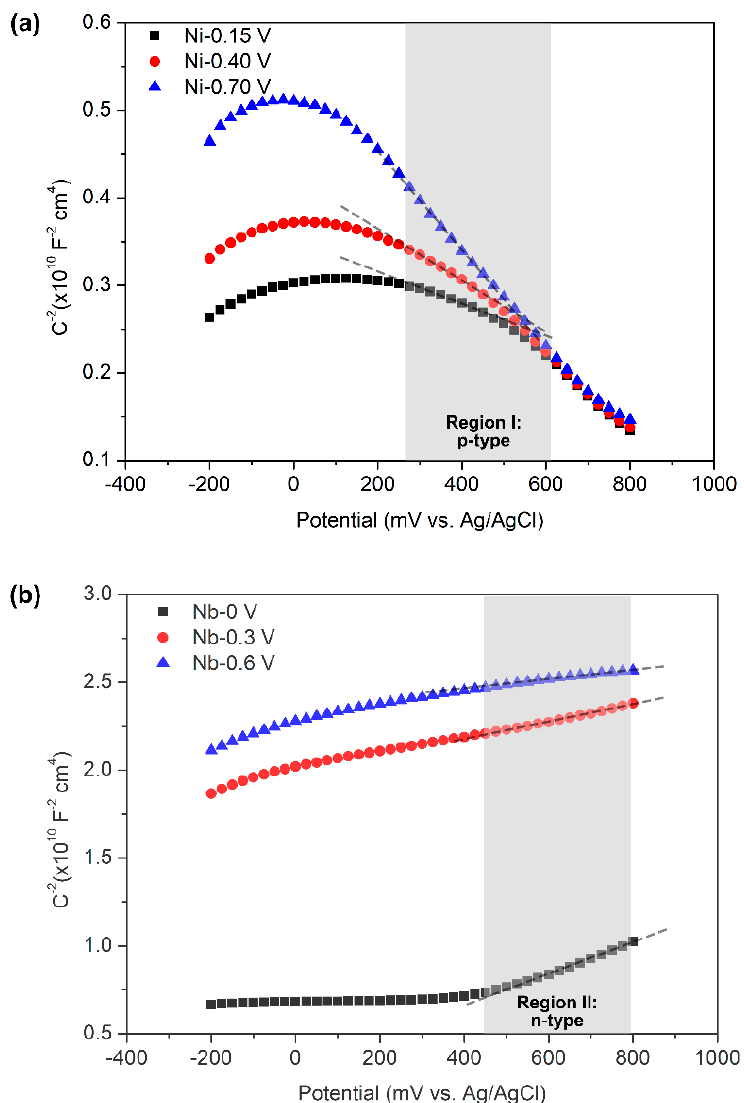
Figure 13. Mott–Schottky analysis of the metals after passivated at different potentials: ( a ) Ni and ( b ) Nb.